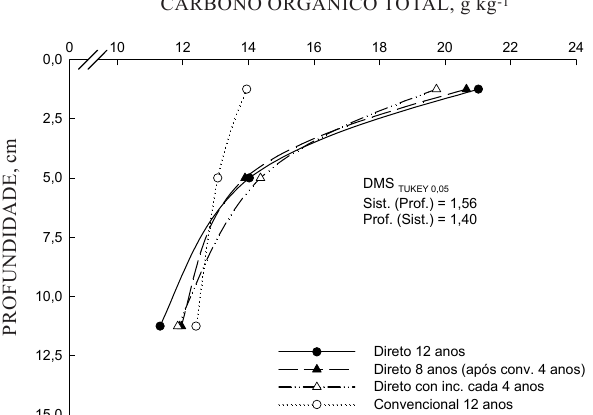
Figura 6. Carbono orgânico total do solo em diferentes sistemas de manejo e